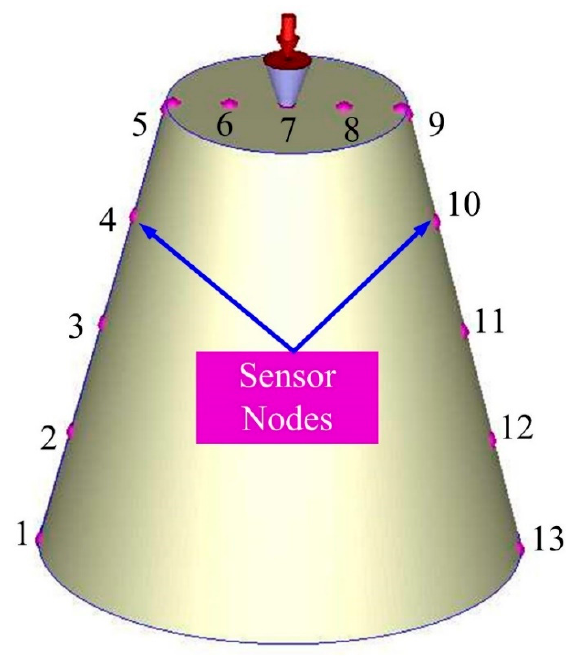
Figure 7. Locations of sensor nodes.